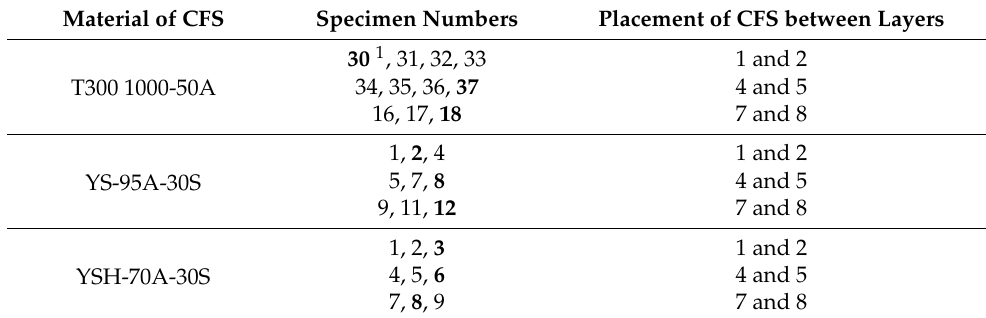
Table 1. Overview of specimens for mechanical tests.